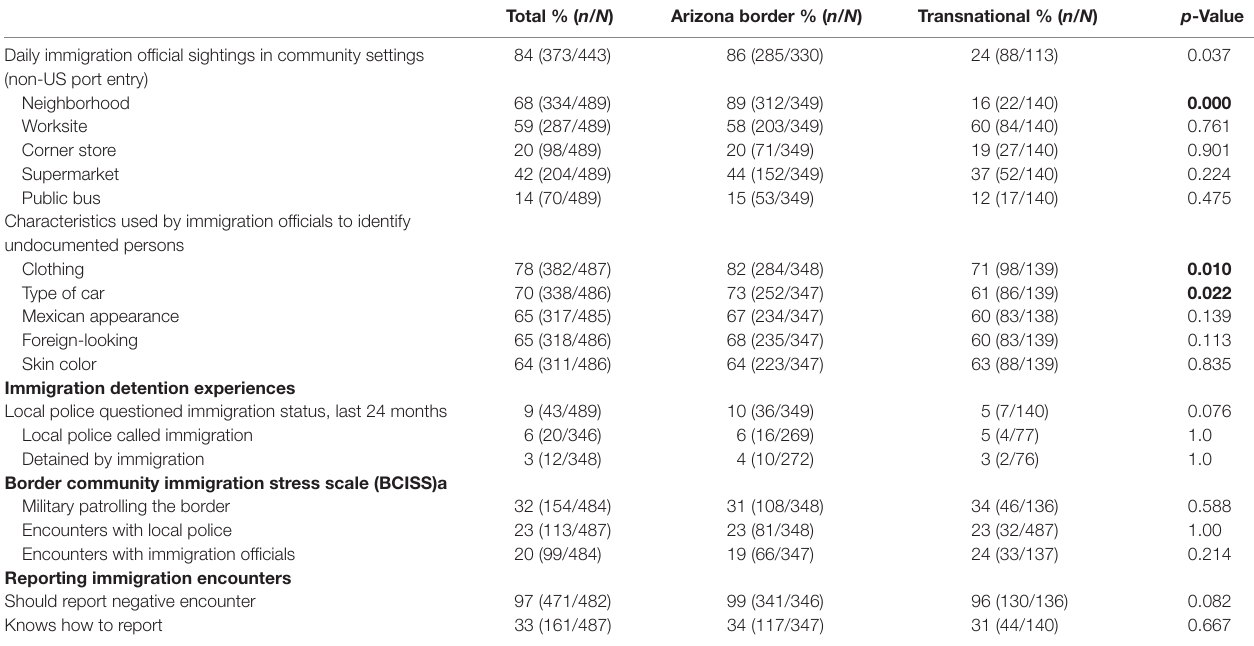
TaBle 2 | comparisons of experiences and encounters with Us immigration and local police among arizona-border and transnational farmworkers. Total % ( n / N ) arizona border % ( n / N ) Transnational % ( n / N